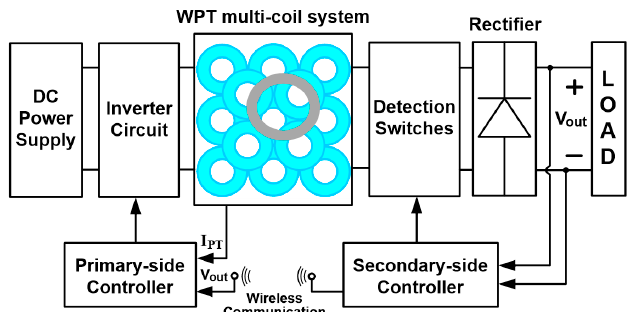
Figure 1. Overall block diagram of the proposed system.